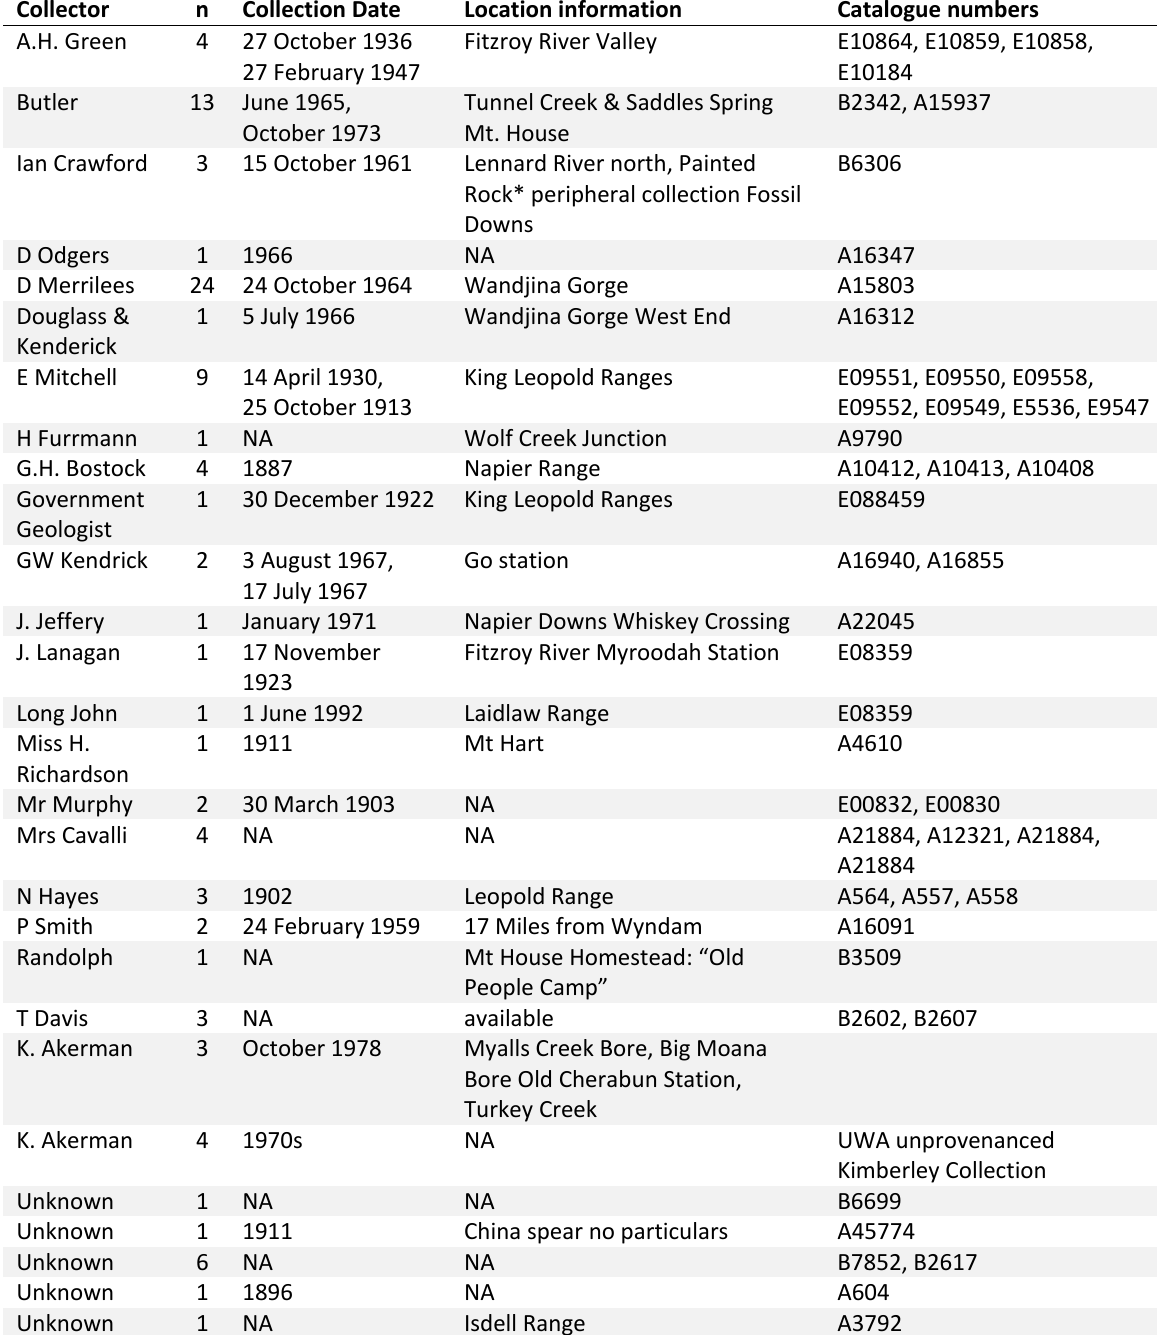
Table 2. Ethnographic collection from the southern Kimberley, listing collectors, collection date and WAM catalogue numbers. n/a depicts information not available. Abbreviations: * Collected from Moongaroonggoo (Maloney et al. 2017b); NA - not